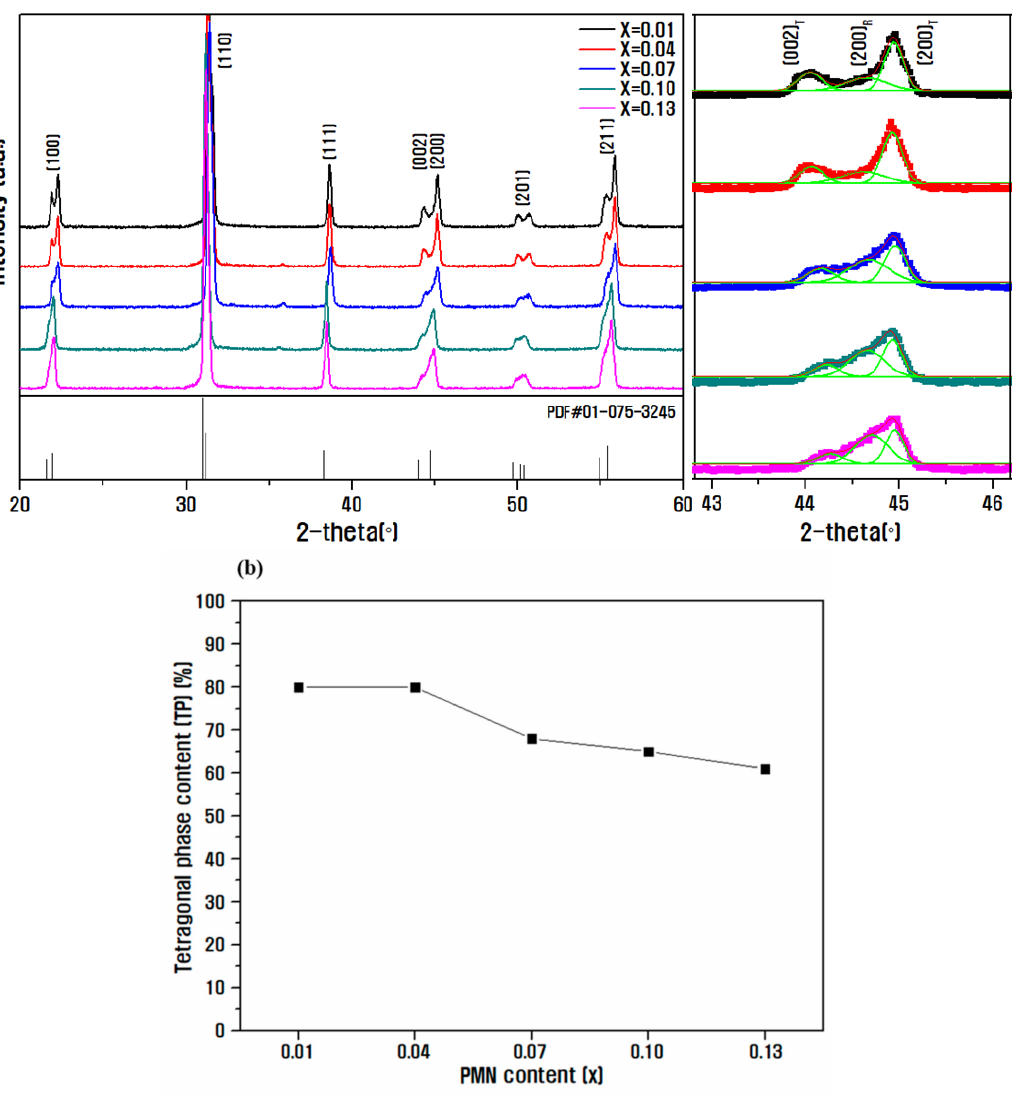
Figure 1. ( a ) X-ray diffraction pattern analysis results according to PMN molar ratio, and ( b ) tetrago- nal phase fraction results in the (0.15-x)Pb(Ni 1/3 Nb 2/3 )O 3 -xPb(Mn 1/3 Nb 2/3 )O 3 -0.85Pb(Zr 0.5 Ti 0.5 )O 3